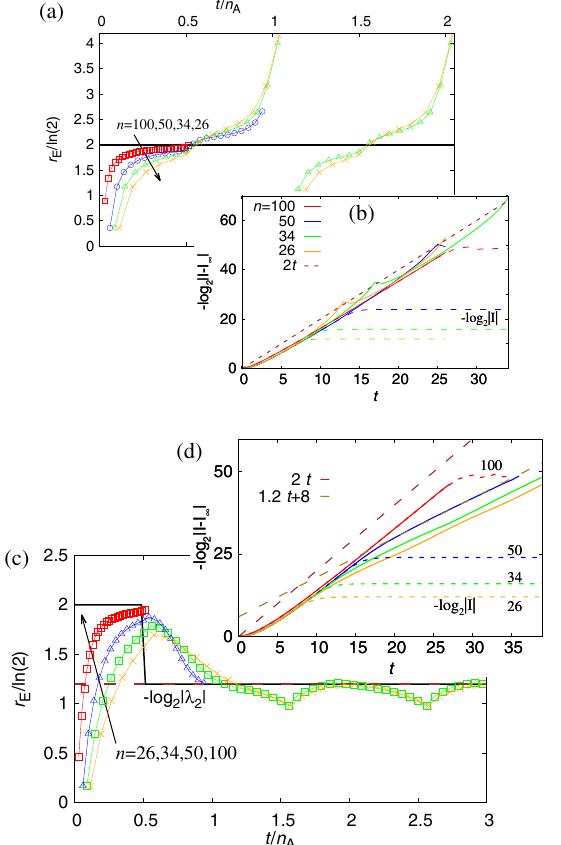
FIG. 8. Entanglement rate for the BW and OBC. Panels (a) and 0 (the XY gate), and (c) and (d) are for a (b) are for a z ¼ 0 , the local rate is always equal to ln 4 in the TDL. For For a z ¼ a 0 . 5 , the conjectured rate in the TDL [full black line in (c)] is z ¼ t n = 2 and smaller − ln j λ ln 4 for t < t ∞ ¼ c ¼ A dashed brown line in panel (c) is at 1.2 and is approximately equal to − ln 2 j λ 2 j from Fig. 4.